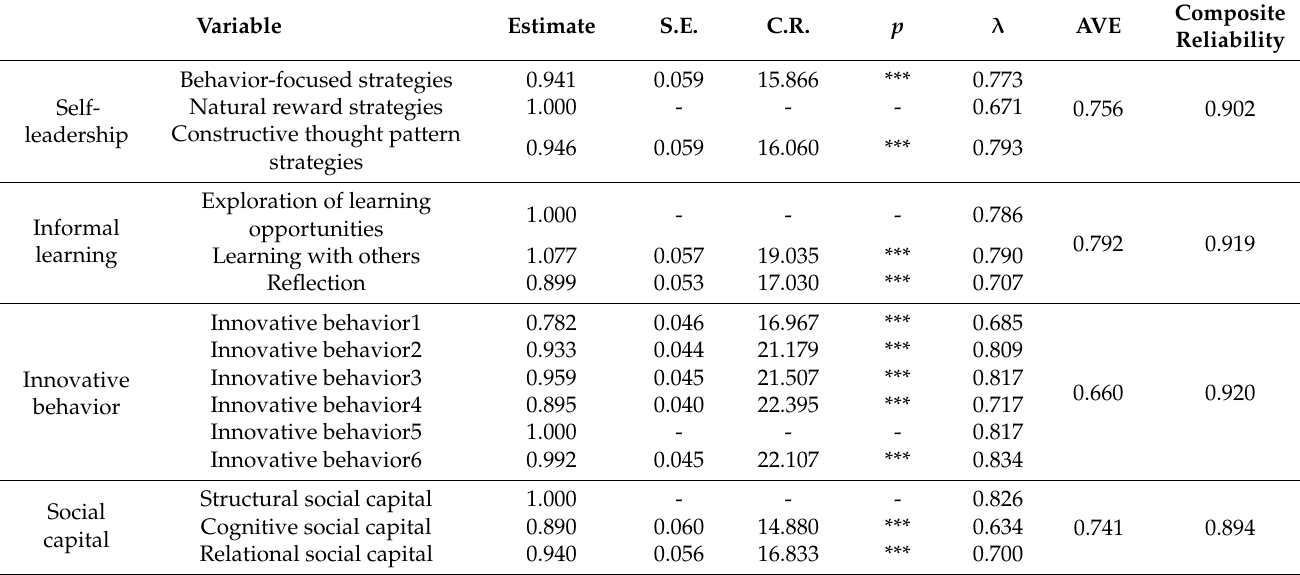
Table 2. Validity analysis.